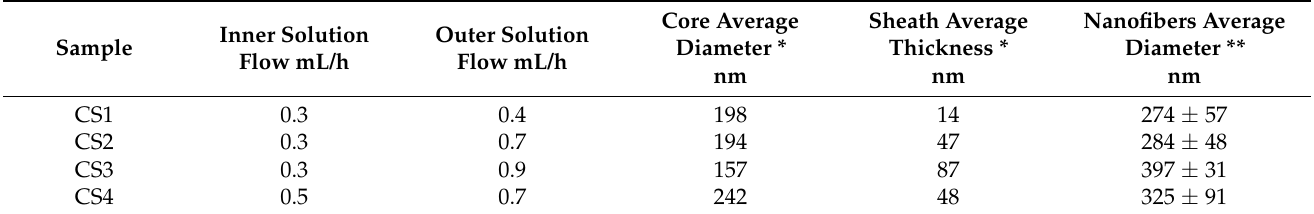
Table 2. Values of core diameters and sheath thicknesses of core-sheath nanofibers with corresponding electrospinning flow rates.